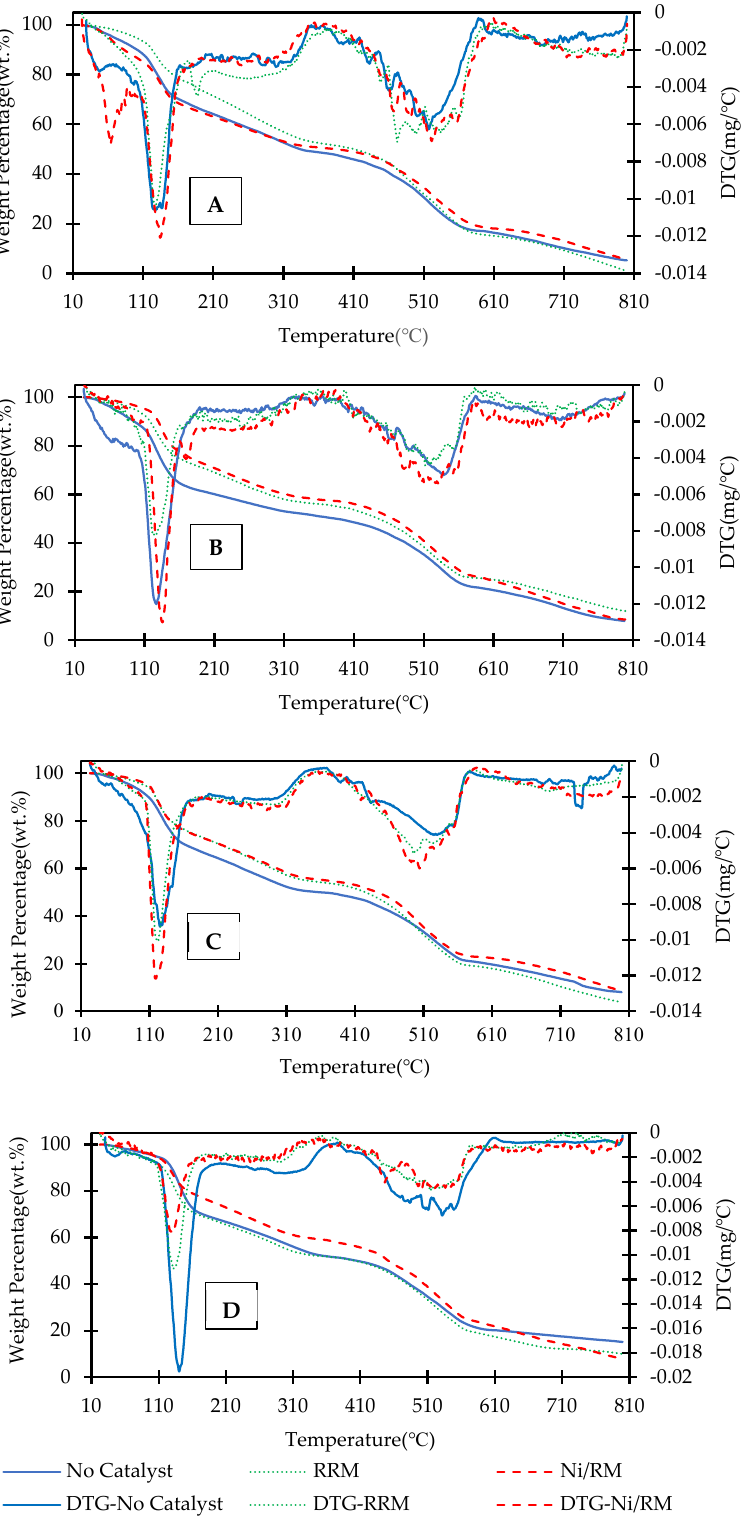
Figure 3. Thermogravimetric analysis of biocrude samples from non-catalytic and catalytic reactions: ( A )—Nitrogen, ( B )—Ethylene, ( C )—Reducing and ( D )—Oxidizing reaction